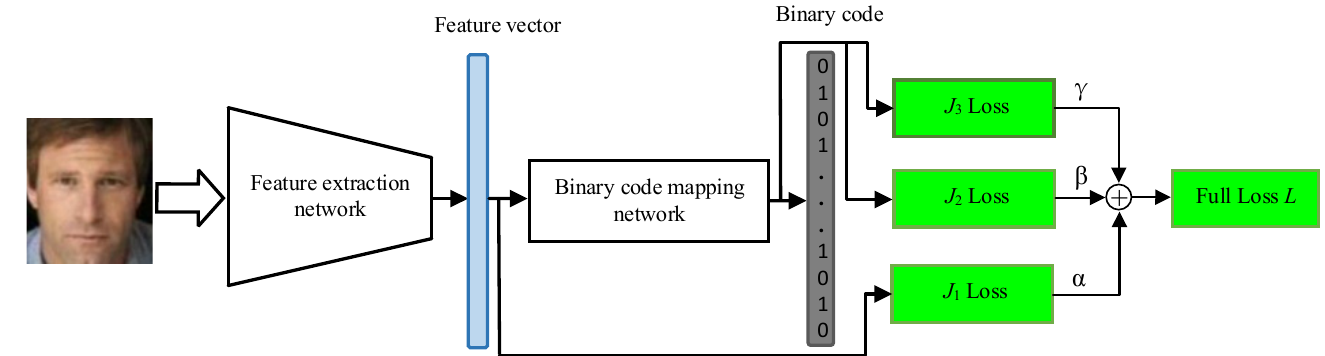
Figure 3. The framework of our proposed biometrics mapping network based on a DNN for generating binary code. This architecture consists of a feature extraction network and a binary code mapping network.